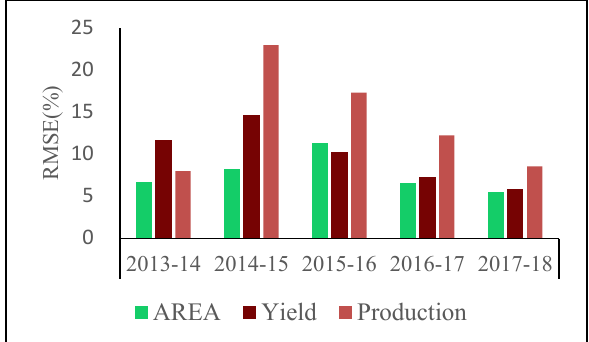
4.3 Comparison RMSE (%) & Correlation Coefficient(R) RMSE (%) have improved over the years from 2015 to 2017 due to the improved satellite resolution (Sentinel-2, MSI,10m), (Table 1) and ground truth data (Figure 3b). Correlation coefficient is very high between DES and FASAL estimates of more than 0.995 (Figure 9). Similar correlation coefficient was observed for production, except for the year 2014-15 which may be because of heavy rainfall and hailstorm events occurred in major wheat growing areas of the country during February and March 2014-15 that have caused large scale damages to the crop. Singh et al, (2017).